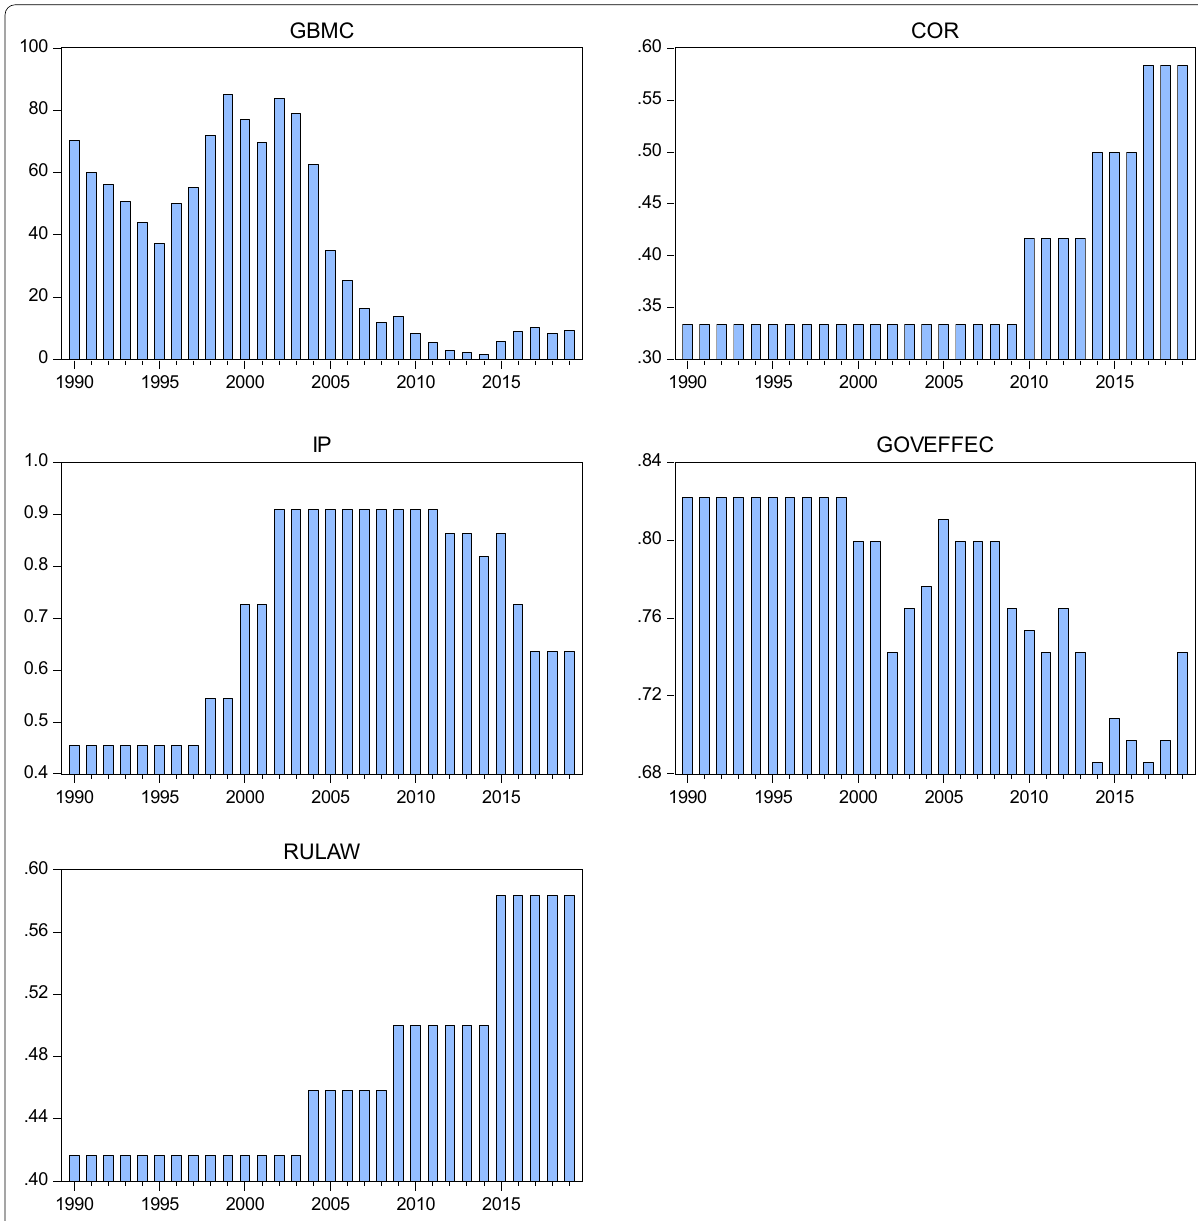
Fig. 3 Graphical representations of the variable of model